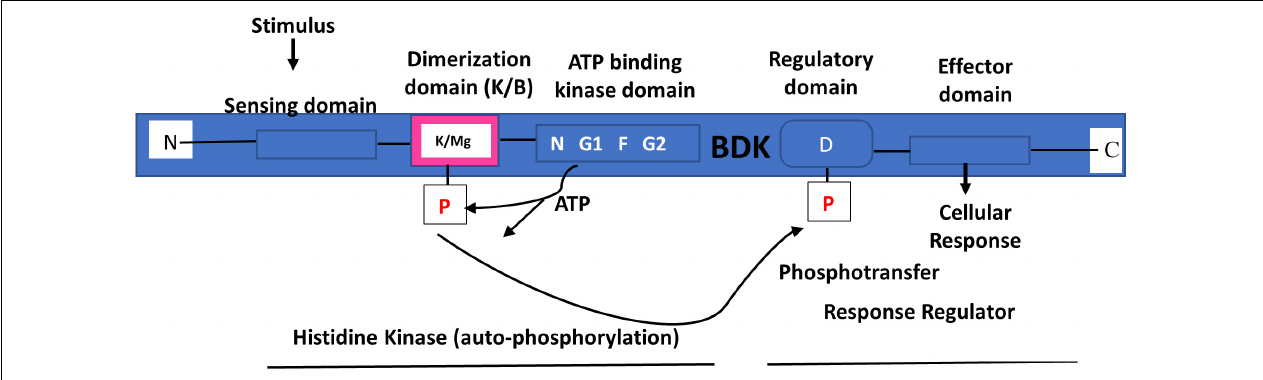
FIGURE 7 | Branched-chain ketoacid dehydrogenase kinase structure and the two-component signal transduction pathway. BDK contains ATP kinase domain with conserved N, G1, F, and G2 motifs. The phosphorylation of BCKDH by BDK is mediated by magnesium (Mg) and potassium (K). Drawn using information from Machius et al.